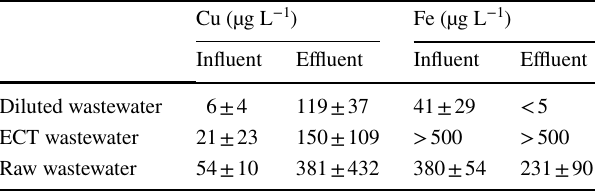
Table 2 Concentrations of Cu and Fe measured in the pilot influents and